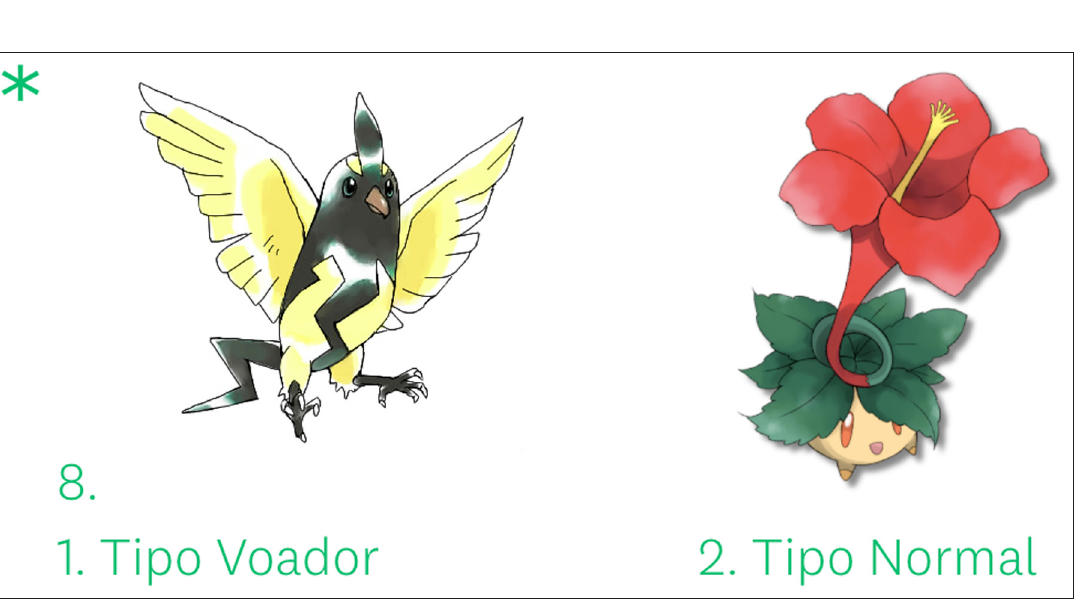
Figure 3: Example of Figures used in Experiment 2; subtitles say “1. Flying-type, 2.